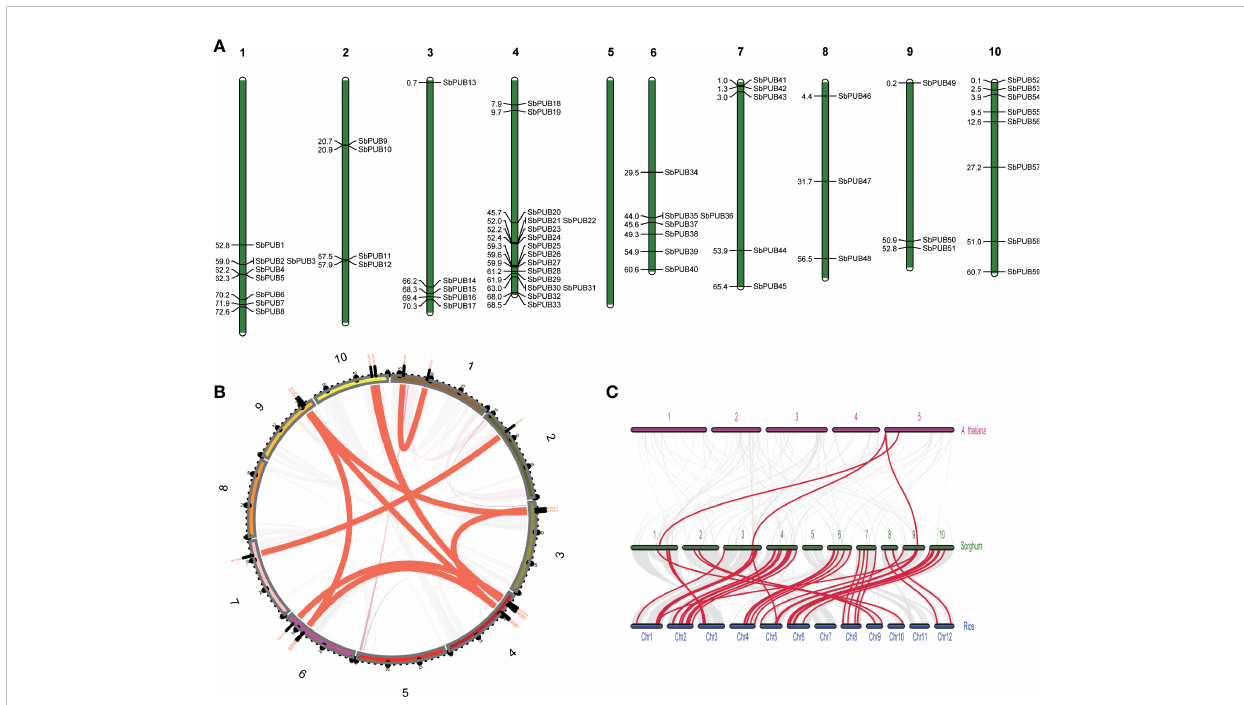
FIGURE 3 The location and synteny of SbPUB genes in the sorghum genome. (A) The distribution pattern of PUBs in 10 sorghum chromosomes. (B) The distribution pattern synteny analysis of SbPUB genes. The red lines represent the synteny gene pairs of PUB gene families in sorghum. (C) Collinearity analysis between sorghum, rice, and A thaliana . The gray lines represent the co-collinearity of all genes between different species, and the red lines represent the collinearity between different members of the PUB gene